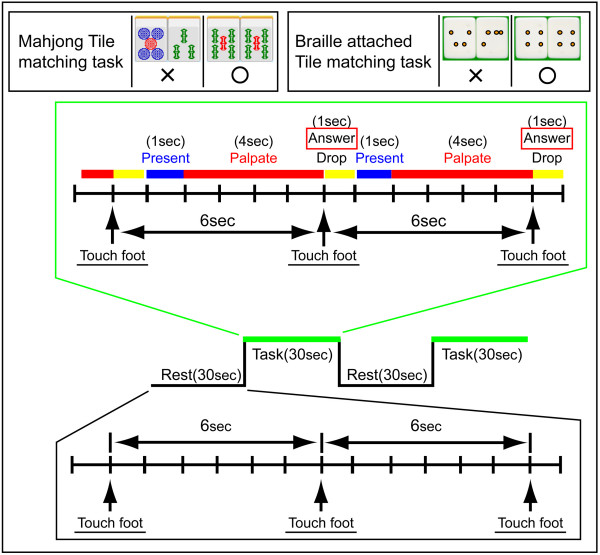
Experimental design (after [10]). Mah-Jong or Braille tile patterns were presented manually. During tactile matching, the subjects closed their eyes and a block of two joined tiles was placed in their right palm for them to feel with their right thumb. If the patterns were the same, the correct response was "yes", and subjects pressed a button with their left index finger. If the patterns were different, subjects signaled "no" by pressing a different button with the left middle finger.